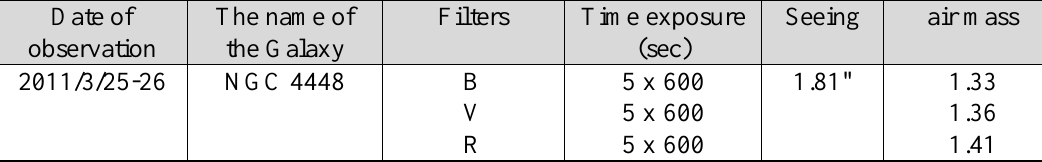
Table 1: Log of observations.